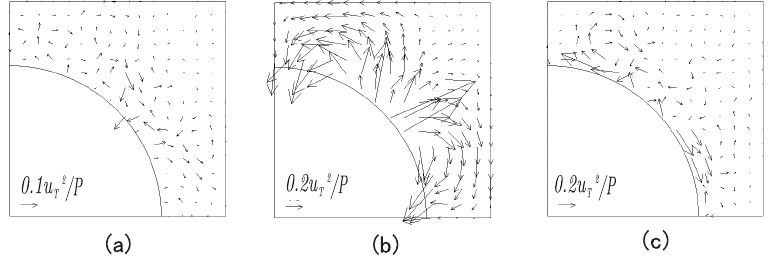
Fig. 6 Imbarances between the terms in momentum equation and the corresponding